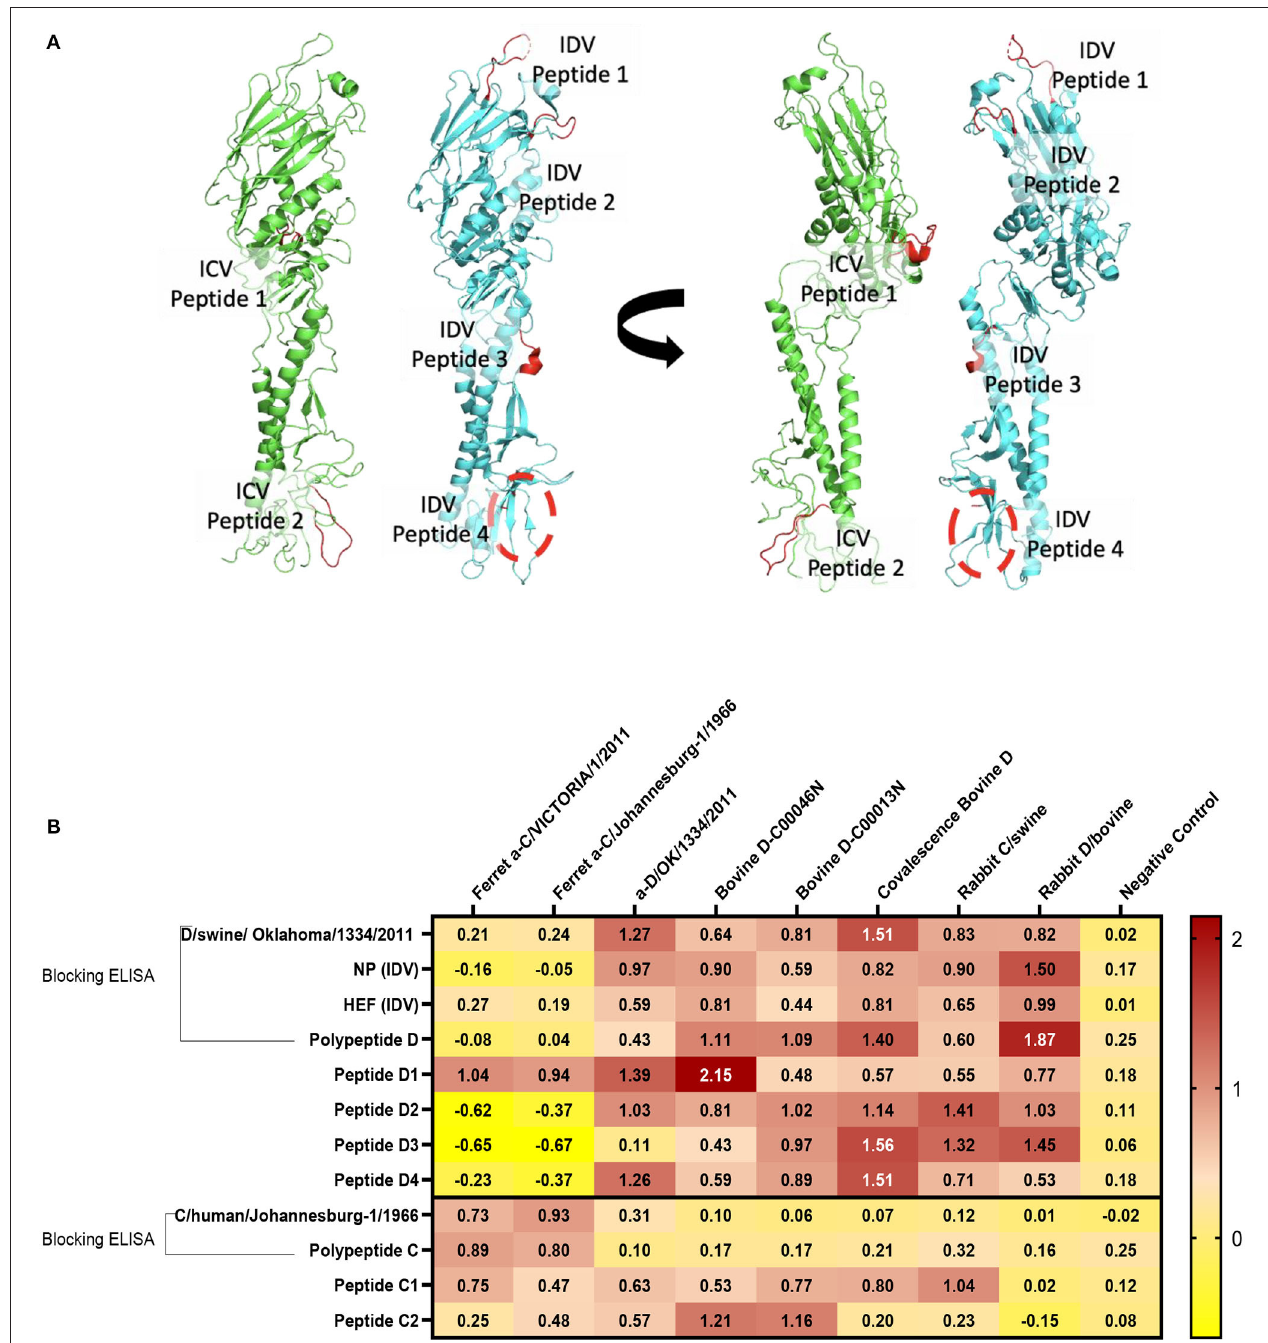
FIGURE 4 | Differentiation between IDV and ICV. (A) Structural representation of the haemagglutinin esterase fusion glycoprotein from the influenza C virus in green (PDB:1FLC) and the influenza D virus in blue (PDB:5E64). Peptides of interest are represented in red. ICV peptide one is found in esterase domain one and has the sequence RTDKSNSAFPRSAD. ICV peptide two is found in fusion domain two and has the sequence GSRKESGGGVTKES. IDV peptide one is found in the receptor domain and has the sequence AESSVNPGAKPQVCGT. IDV peptide two is also found in the receptor domain and has the sequence IANAGVK. IDV peptide three is found in the fusion domain and has the sequence KTDSGR. An enzymatic cleavage site was noted adjacent to IDV peptide three. IDV peptide four falls within a 17 amino acid region not represented in structural data. Its location is highlighted with a dashed circle. IDV peptide four has the sequence RTLTPAT and occupies the fusion domain. (B) NP, HEF, and IDV antigens were blocked by anti-ICV antibodies. ICV was blocked by anti-IDV antibodies. Compared to blocking ELISA, polypeptides and single peptide ELISA had higher sensitivity and specificity of peptides to differentiate between IDV and